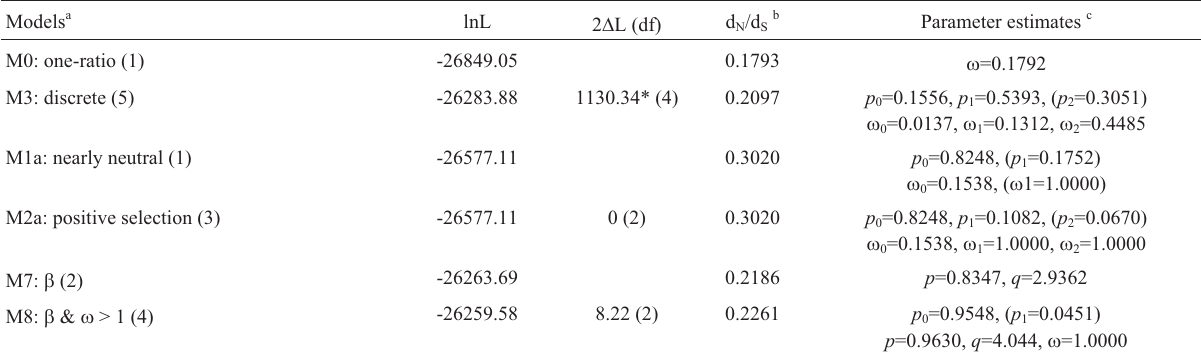
Table 1 - Parameter estimates, likelihood scores under models of variable (cid:5) ratios among sites for alcohol dehydrogenase proteins. Models a